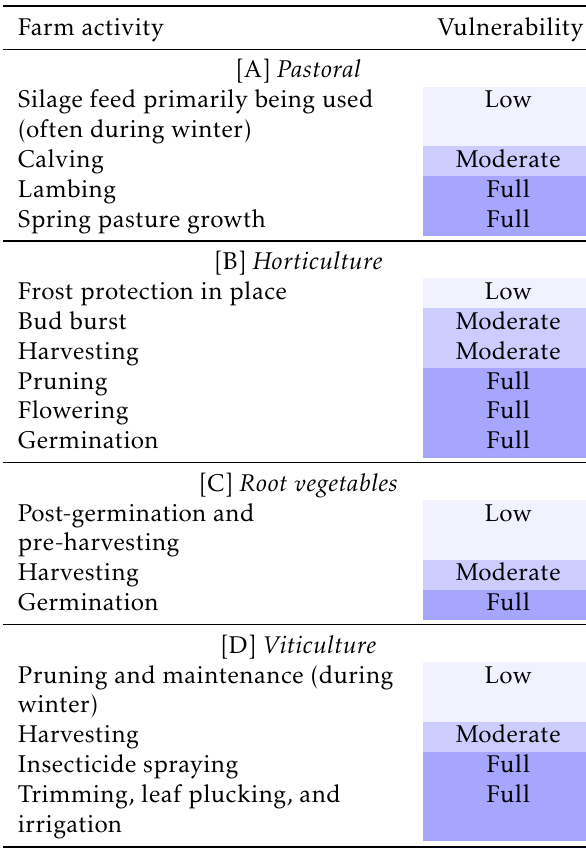
Table 2: Generic vulnerability levels, based on the New Zealand agricultural calendar, for farming types [A] pas- toral; [B] non-tree fruit, tree fruit, leafy vegetables and cereals; [C] root vegetables; and [D] viticulture, with farm activities and growth stages. These activity levels were used to define the vulnerability levels used to create the functions and temporality/seasonal